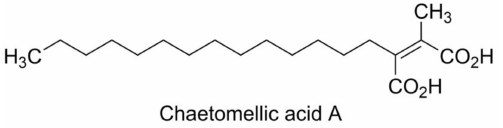
Figure 5. Acyclic natural product RAS inhibitor Chaetomellic acid